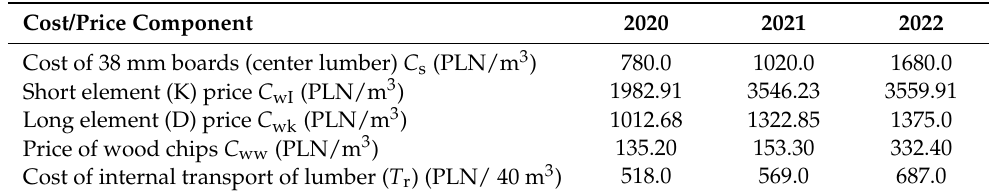
Table 2. The average annual prices for processing lumber into semi-finished furniture